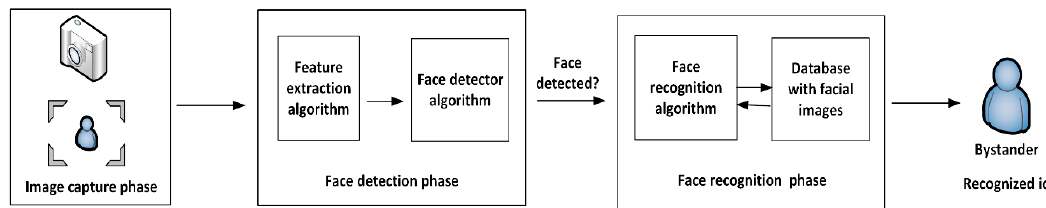
Figure 2. Processes for face detection and recognition.